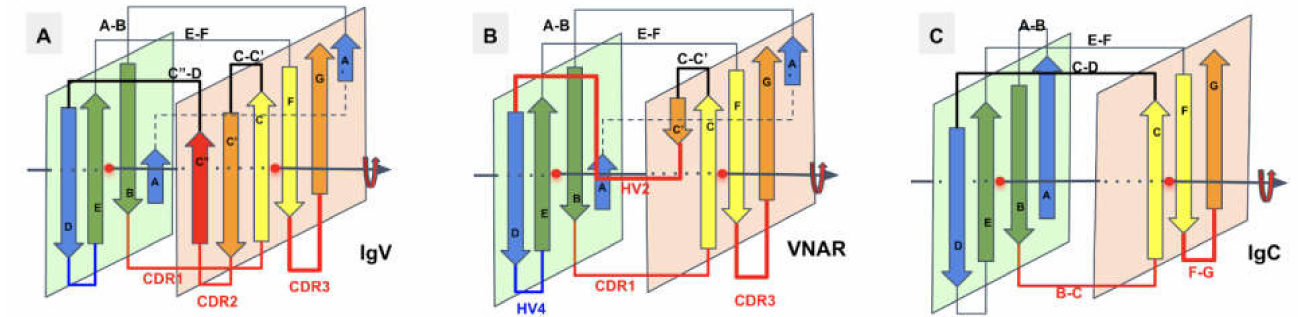
Figure 4. Ig domain topologies for IgV, Shark VNAR, and IgC. ( A ) In IgV domains, the A strand has a flexible hinge in the middle, usually a cis-proline or a stretch of glycines and swaps the upper part of the strand (noted A’) to Sheet B. ( B ) VNAR shows that same domain level organization with two protodomains, yet a much smaller inter-protodomain linker, eliminating the linker’s secondary structure as present in IgV domains: the C” strand and the CDR2 loop. Instead, a short HV2 is observed. In the literature, the C’ strand is usually included in the HV2 region, as it is extremely short. In addition, a hydrophilic set of residues facing out on Sheet B (GF|CC’), rather than being hydrophobic in IgV, do not permit the formation of a symmetric dimer. Dimerization in crystal structures can be observed through HV2, yet they may not be relevant biologically. ( C ) IgC. Here, we consider only the IG C1 set, i.e., the antibody-constant domain-like set, to exemplify an additional protodomain connectivity. In this case, the final domain is formed by a full 4-stranded AB|ED (Sheet A) vs a 3-stranded GFC Sheet B, and no C’ strand. Interestingly, this enables the domain-level dimerization through that 4-stranded Sheet A to form an 8-stranded barrel, as opposed to the IgV that uses the opposite Sheet B to form an 8-stranded dimer